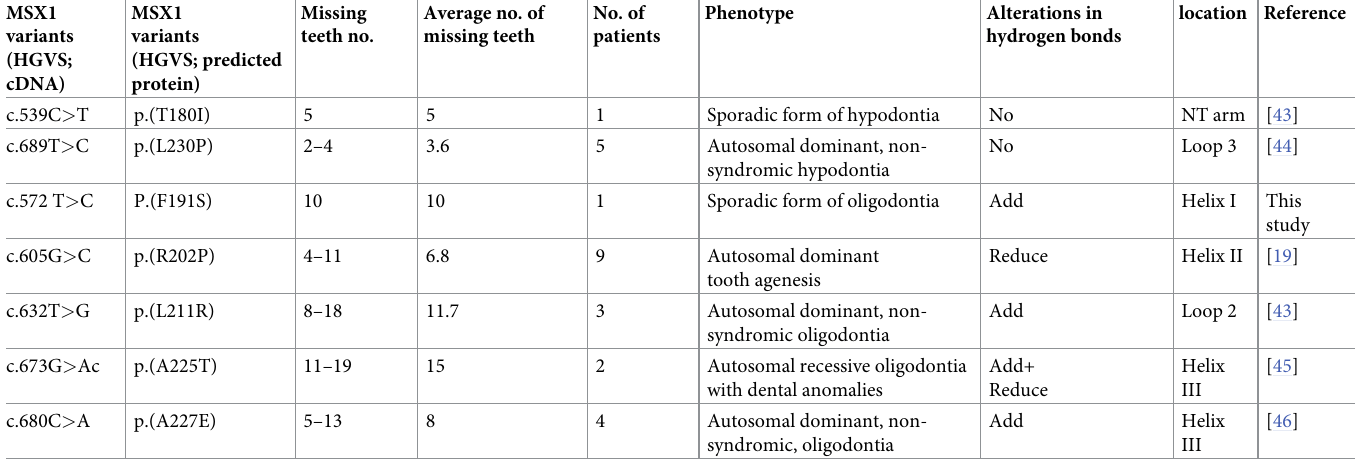
Table 1. MSX1 homeodomain missense variants in subphenotypes of increasing severity of non-syndromic tooth agenesis (NSTA) and alterations in hydrogen bonds.